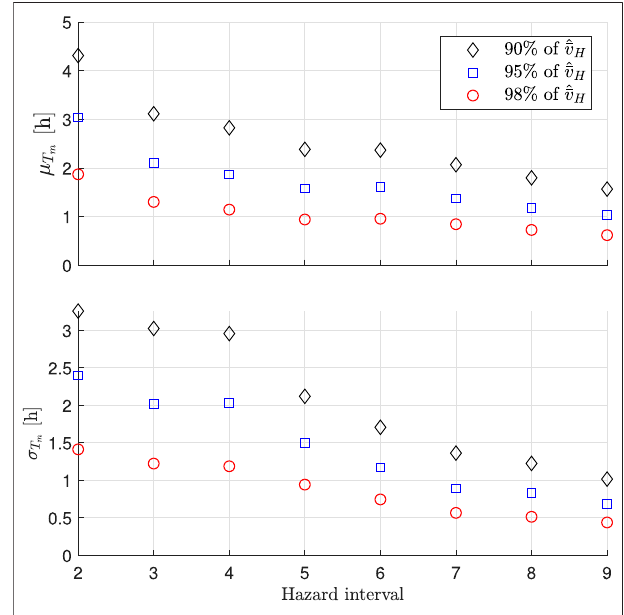
FIGURE 10 | Mean, μ T hazard intensity intervals three to nine.